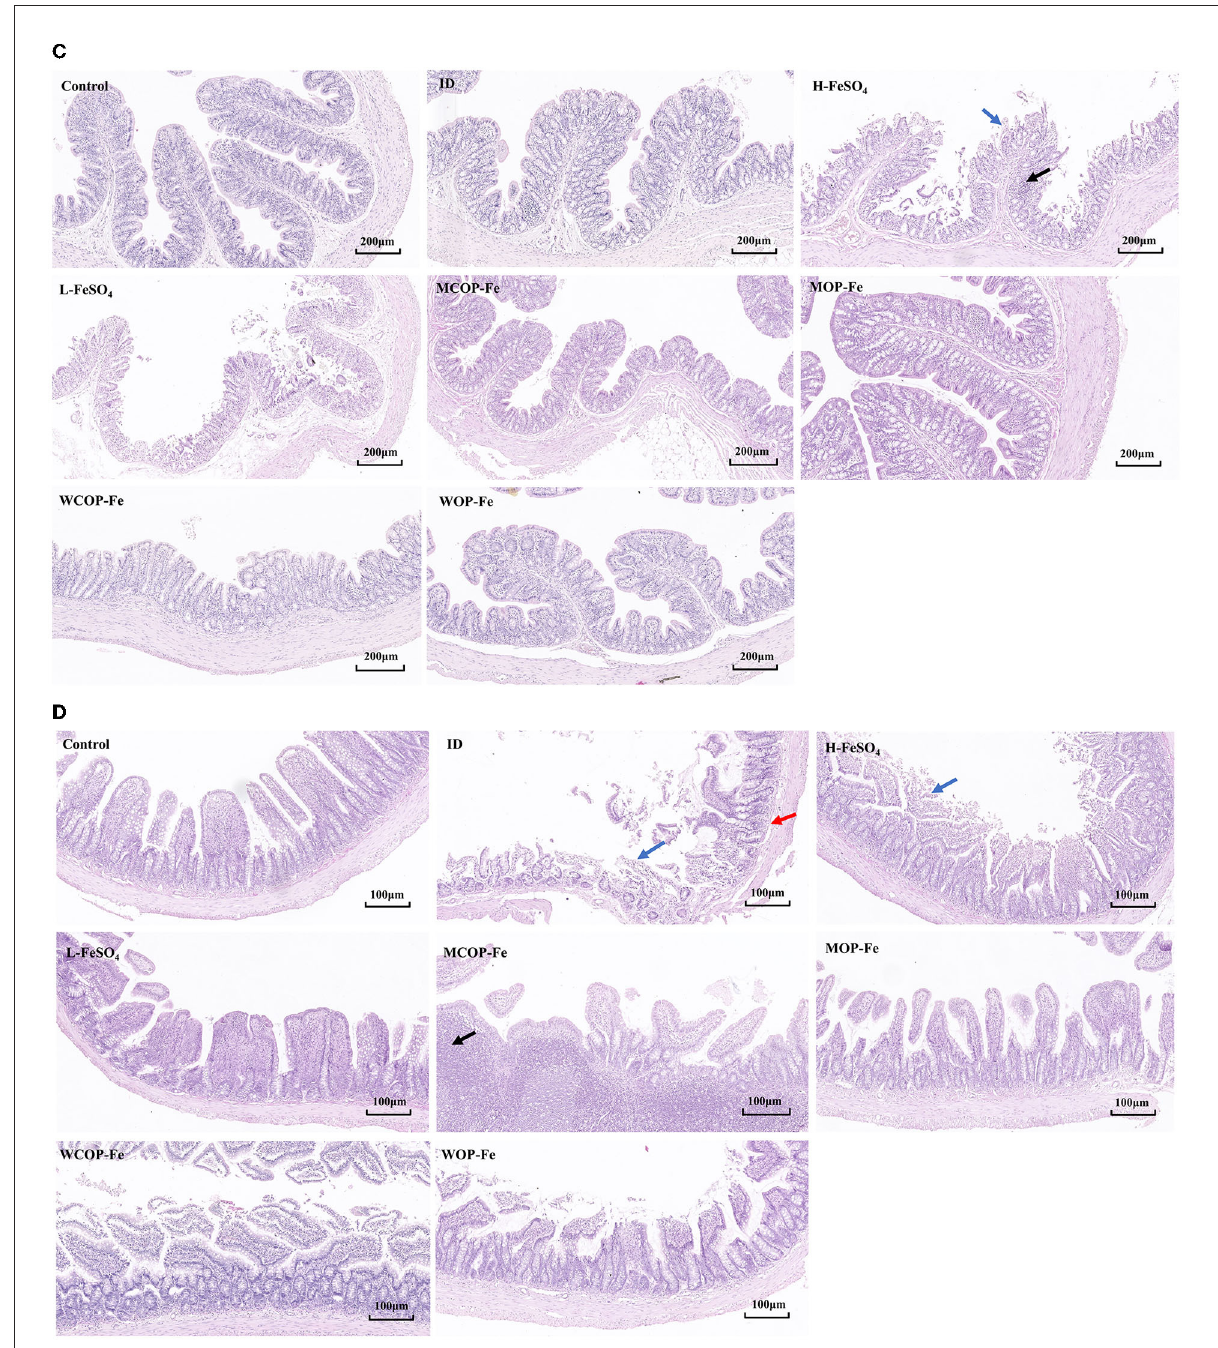
FIGURE5 Hematoxylin-eosin staining results about liver and intestinal tissue sections of IDA pregnant rats. (A) Liver tissue sections of 8 groups. Black arrow, extramedullary hematopoietic; red arrow, infiltration of inflammatory cells; blue arrow, lipid drop of cavitation; green arrow, hemosiderin deposition. (B) Duodenum (C) Ileum (D) Colon tissue sections of 8 groups. Blue arrow, mucosal erosion; red arrow, lamina propria edema; black arrow, lymphoid hyperplasia. ID, iron deficiency anemia model group (4 ppm FeSO 4 ); H-FeSO 4 , 400 ppm FeSO 4 ; L-FeSO 4 , 40 ppm FeSO 4